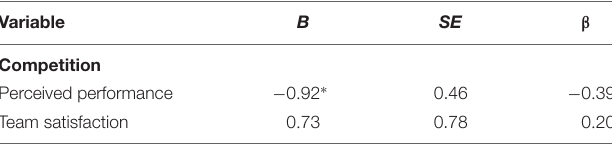
TABLE 2 | Results of regression analysis testing direct effects of competition on outcome